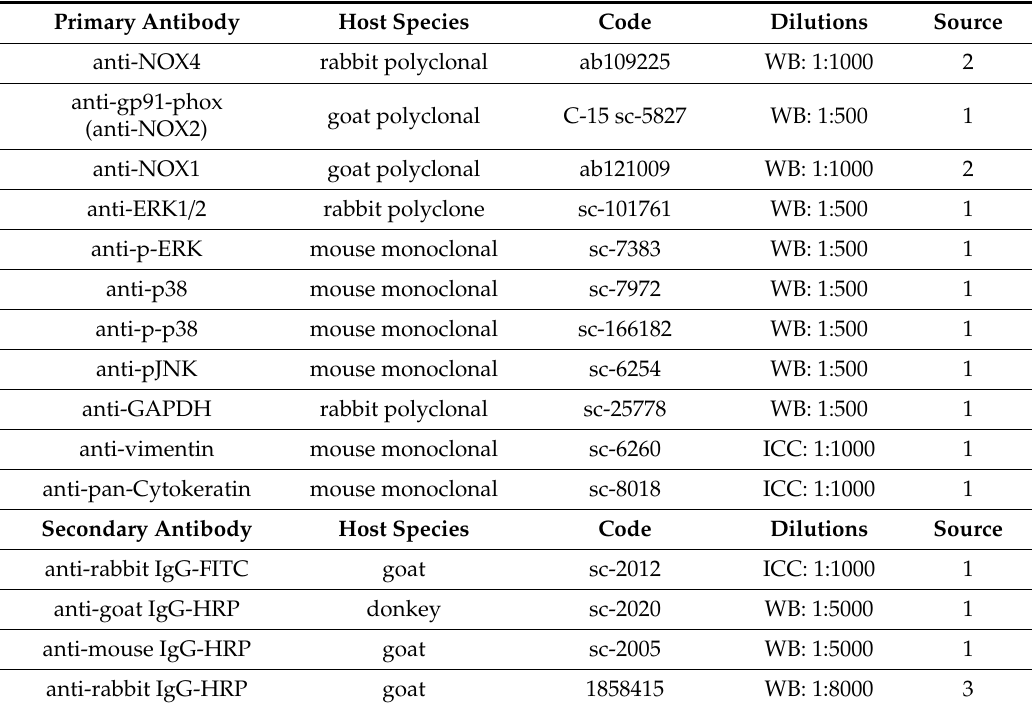
Table 2. Antibodies used in the